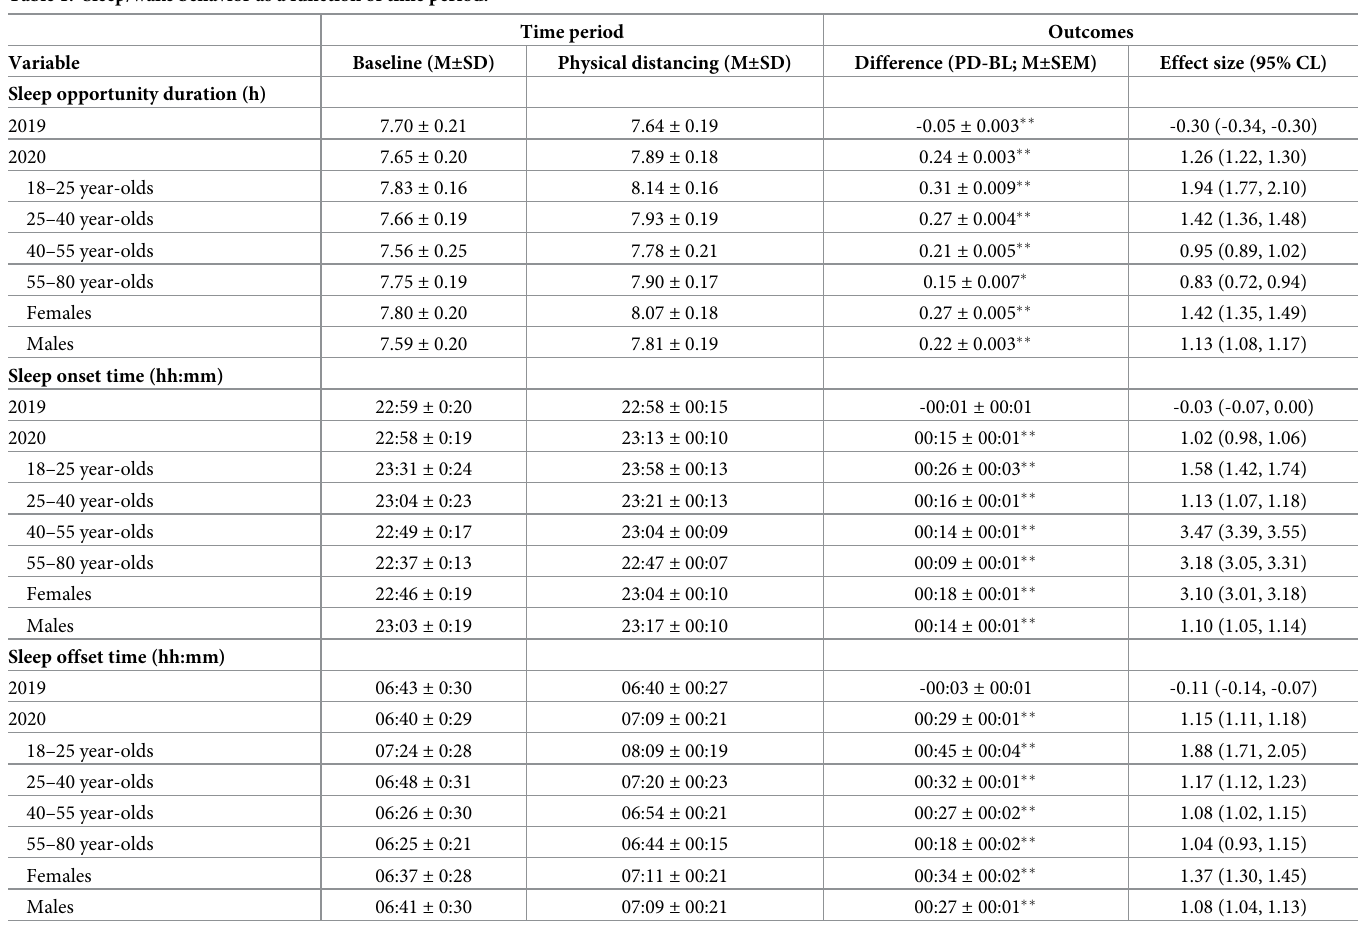
Table 1. Sleep/wake behavior as a function of time